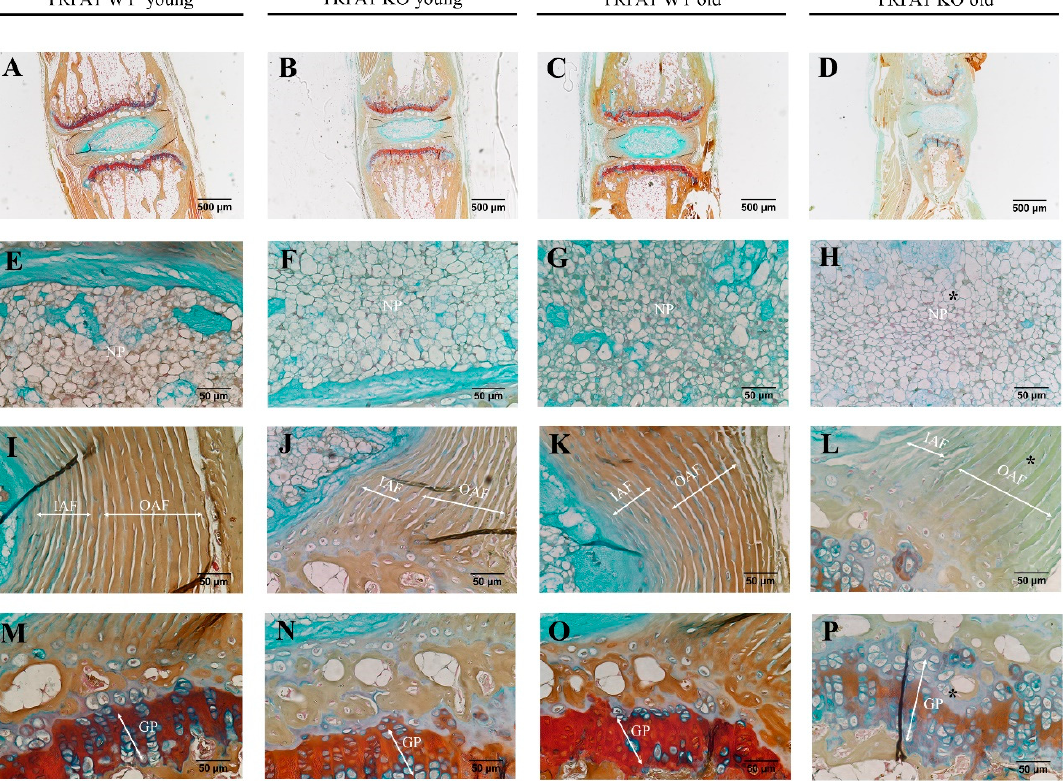
Figure 7. FAST staining of IVDs of TRPA1 wild-type (WT) and knock-out (KO) mice. The tail motion segments of TRPA1 young WT ( A , E , I , M ), TRPA1 young KO ( B , F , J , N ), TRPA1 old WT ( C , G , K , O ), and TRPA1 old KO ( D , H , L , P ) mice. The nucleus pulposus: NP ( E – H ); inner annulus fibrosus: IAF and outer annulus fibrosus: OAF ( I – L ); vertebral growth plate: GP ( M – P ) are also shown in higher magnification. Asterisks (*) indicate depletion of glycosaminoglycan deposition in IVD. Scale bars indicate 500 µm in upper panel ( A – D ), but 50 µm in lower panels ( E – P ).